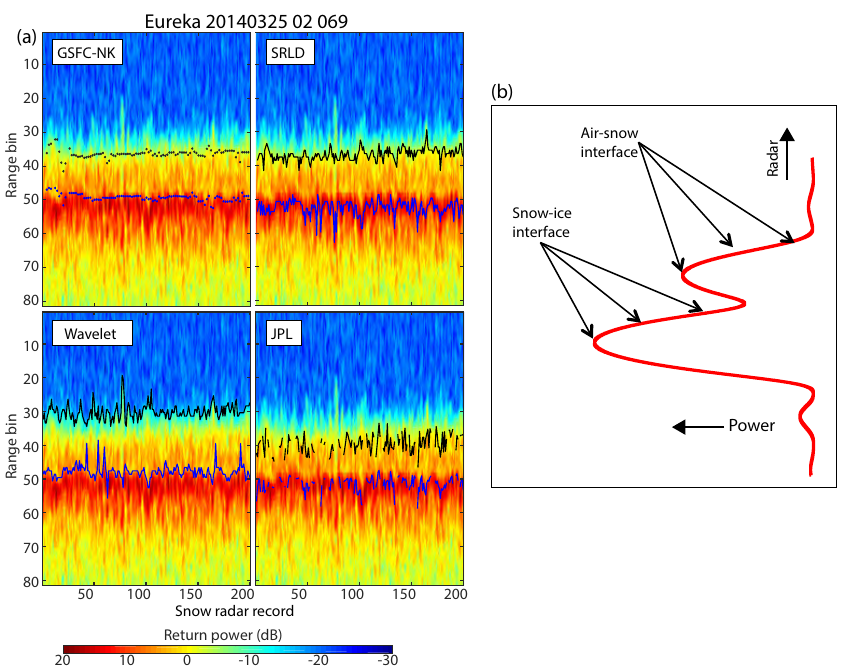
Figure 2. Location of the air–snow and snow–ice interfaces overlaid on power of return echoes. (a) Examples from four algorithms (black trace denotes the air–snow interface; blue trace denotes the snow–ice). (b) Except for the modeled GSFC-NK algorithm, the variability in the interface locations (e.g., leading edge, peak) depends on the algorithm.